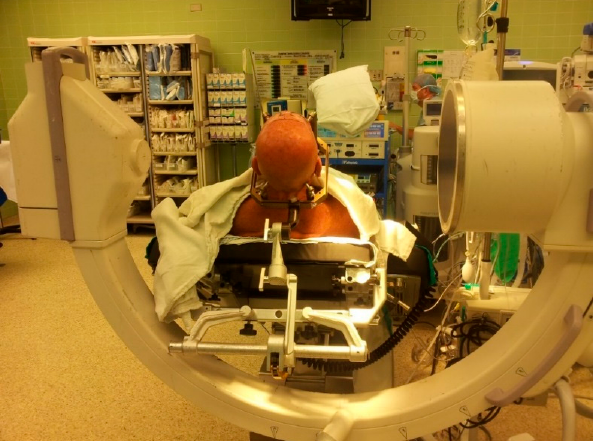
Figure 7. Position of the patient on the operating room table with the Leksell frame fixed to the table through a Mayfield adaptor and the C- arm positioned around the patient.